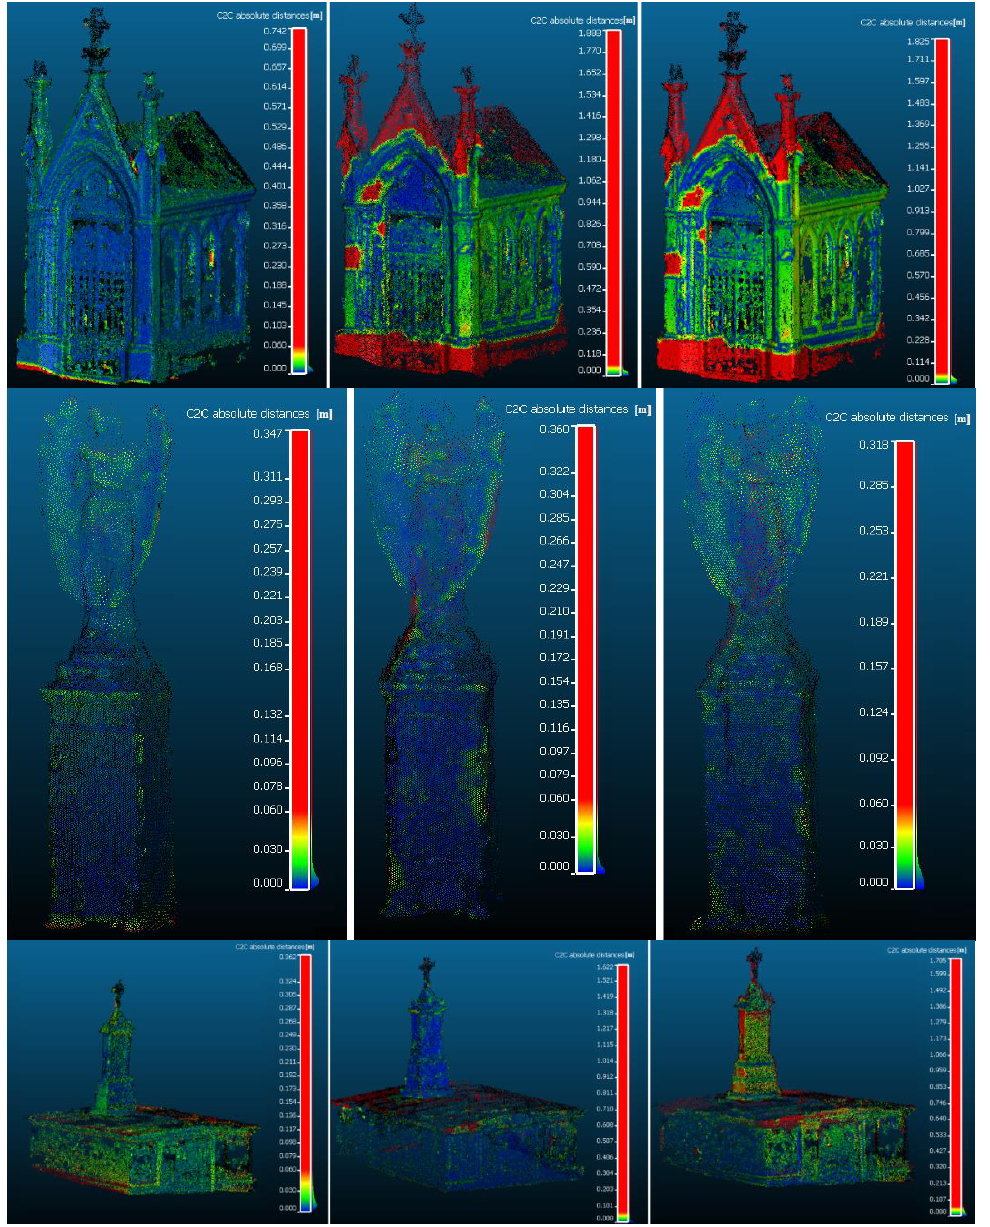
Figure 3. 3D data in comparison – left column: VisualSFM vs. OSM Bundler point cloud, middle column: ARC3D vs. OSM Bundler point cloud, right column: VisualSFM vs. ARC3D point cloud (green +/- 2cm; red over